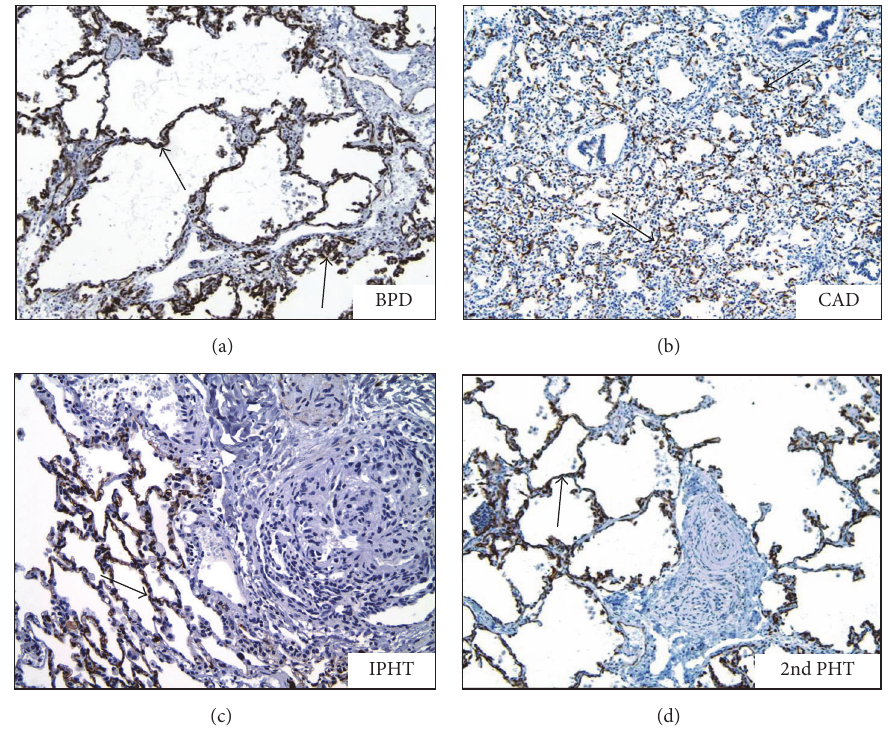
Figure 4: SERT staining is diffusely present in various pulmonary hypertension disorders other than ACD/MPV (3,3 󸀠 -diaminobenzidine, arrows showing SERT antibody expression in brown) . BPD: bronchopulmonary dysplasia (200x, arrows), CAD: congenital alveolar dysplasia (100x), IPHN: idiopathic (primary) pulmonary hypertension (200x), and 2nd PHT: secondary PH due to congenital heart disease (200x).